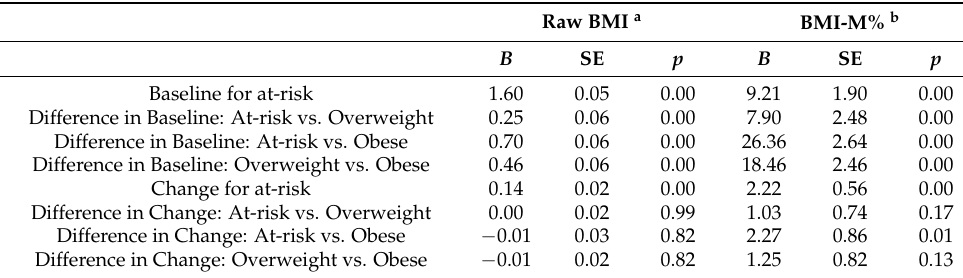
Table 4. Control Group Baseline and Change Differences in BMI